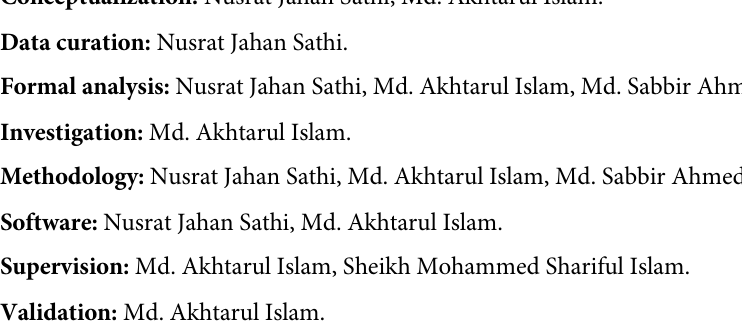
S2 Table. Test results of Variance Inflation Factor (VIF). S3 Table. Baseline characteristics of the study participants aged 35 and over from Bangla- desh demographic and health survey (n = 11,686). S4 Table. Test results of Cochran-Armitage